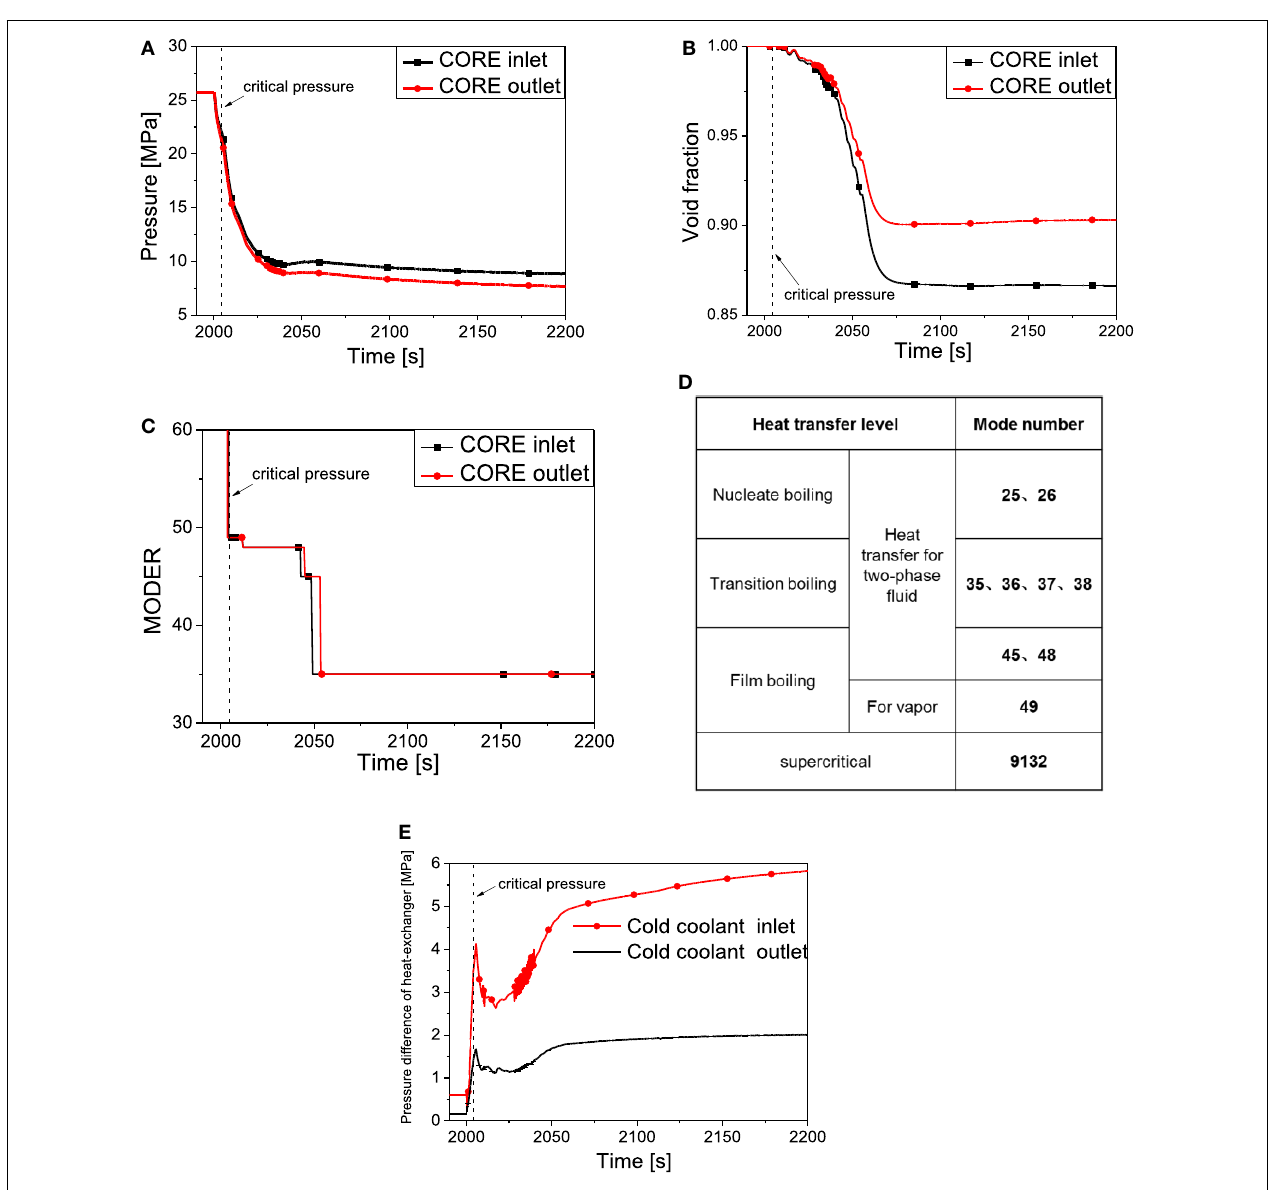
FIGURE 5 | System behavior in transient state (I) . (A) Core pressure. (B) Void fraction of coolant. (C) Heat transfer mode. (D) Heat transfer mode description. (E) Pressure difference of